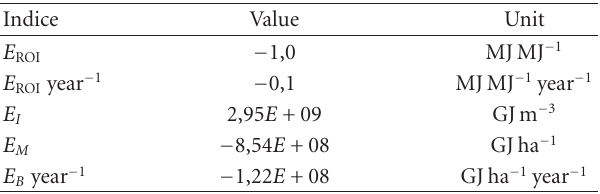
Table 1: Indices of energy e ffi ciency considering solar